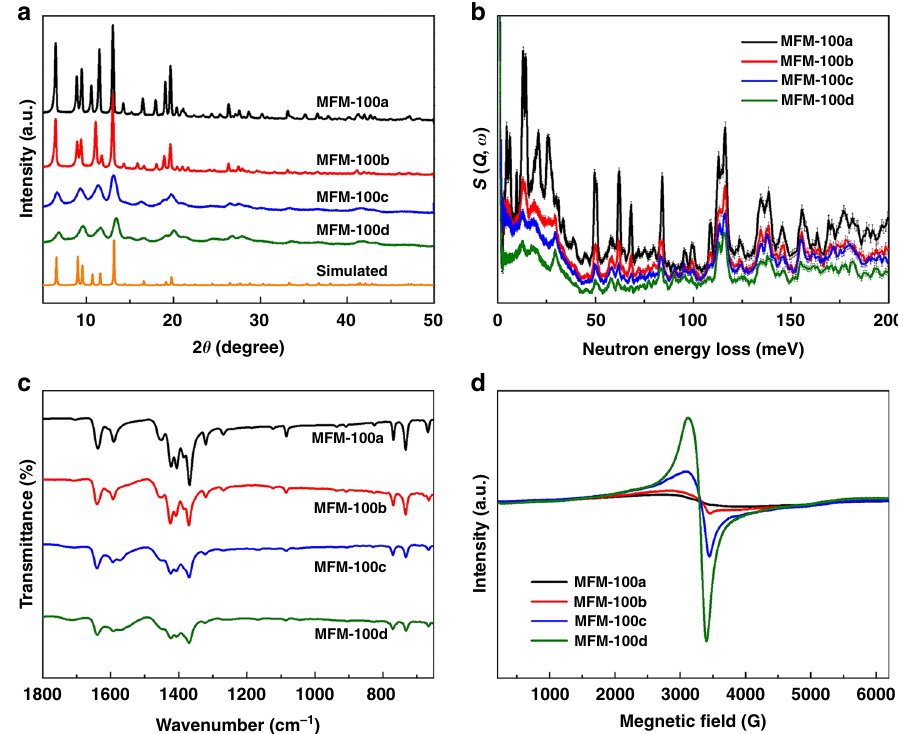
Fig. 2 Characterisation of samples of MFM-100. Comparisons of a PXRD patterns; b INS spectra; c FTIR spectra; d solid-state EPR spectra at same sensitivity and concentration of MOF